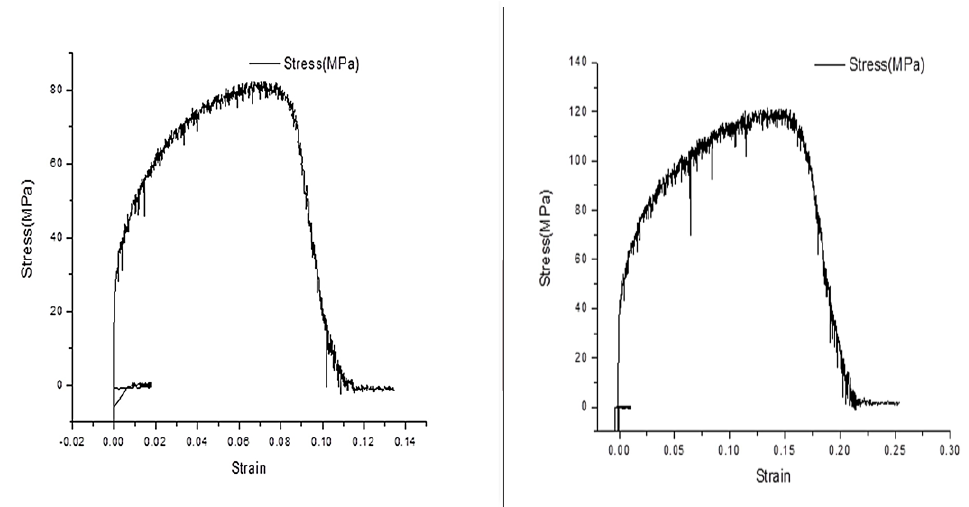
Figure 4. Sample 1A Stress Strain Curve at 800 °C. ( Left ) 0.0001 strain rate, ( right ) 0.001 strain rate [12]. The area under the σ – ε curve up to a given value of strain is defined as the total